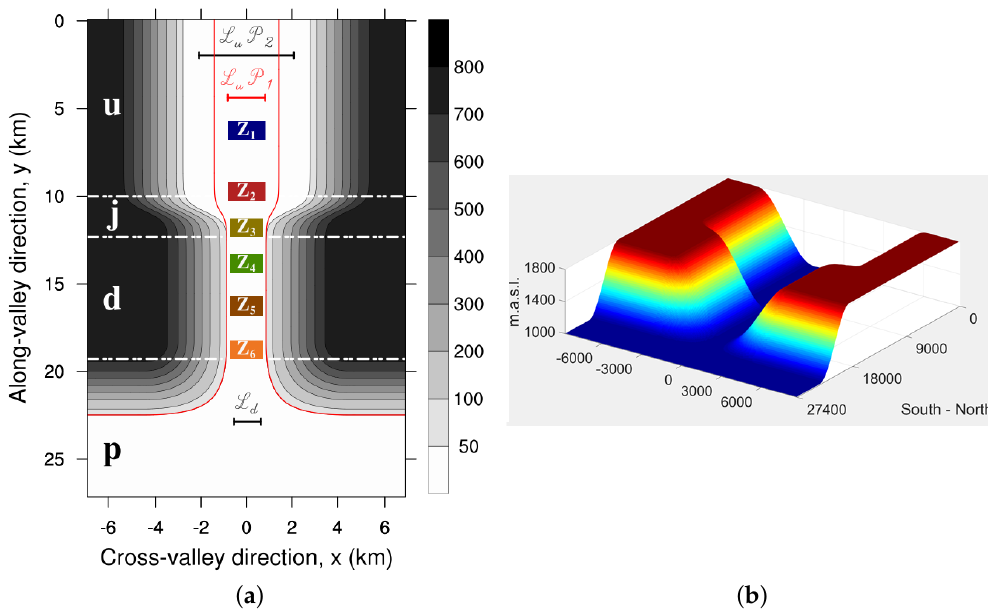
Figure 1. ( a ) Contours of the terrain height in meters from the valley bottom for topography T2; the contours are plotted every 50 m, the first contour of topography T1 being indicated with a red line. The topography is oriented north-south in the y -direction, the valley being symmetric along the y = 0-plane. The valley is composed of three main sections, an upstream section, called U , a downstream section D and a plain P at the end of the valley; sections U and D are linked by a junction J . Six different emission zones are set along the valley axis continuously releasing in each zone the same amount of tracers at a constant rate equal to Q = 2.25 × 10 − 6 kg s − 1 from the initial time during the simulation. The notation used for each tracer is explained in Section 2.4. ( b ) Three-dimensional representation of topography T2. Frames (a,b) display the southern part of the